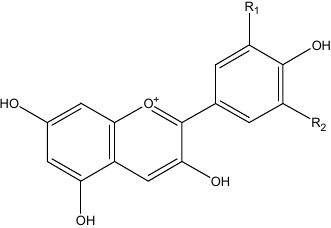
Figure 1. The chemical structures of cyanidin (R 1 = OH, R 2 = H), delphinidin (R 1 = R 2 = OH), peonidin (R 1 = OCH3, R 2 = H), petunidin (R 1 = OCH3, R 2 = OH), pelargonidin (R 1 = R 2 = H) and malvidin (R 1 = R 2 =